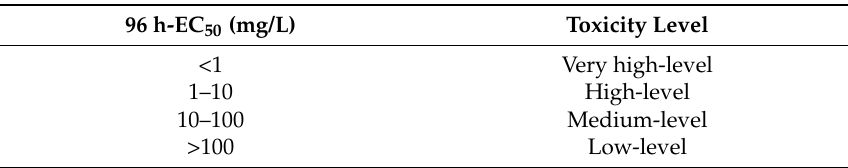
Table 1. Acute toxicity test classification criteria for algae.